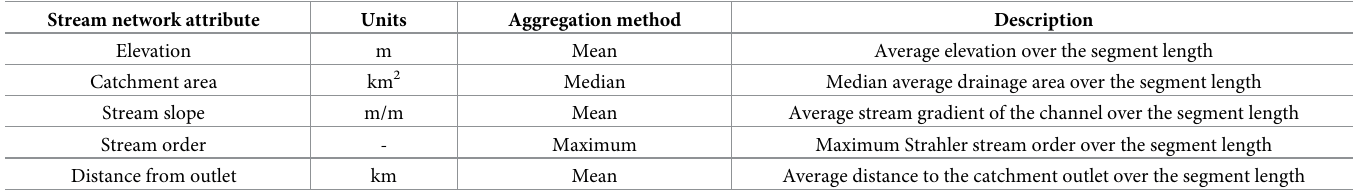
Table 1. Stream network point aggregation over varying segment lengths (0.05, 0.1, 0.2 and 1 km). Note that 1 km segment lengths were included in the ArcGIS web-